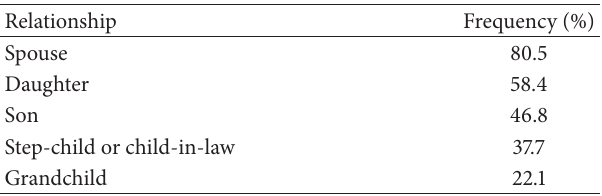
Table2:Fivemostfrequentlyreportedfamilyrelationshipsreported by respondents with